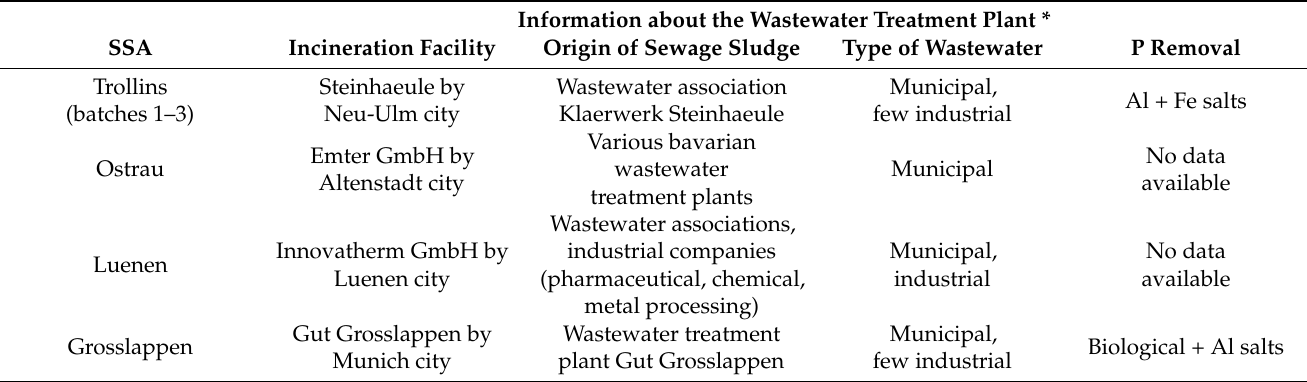
Table 1. Overview of the tested sewage sludge ashes.